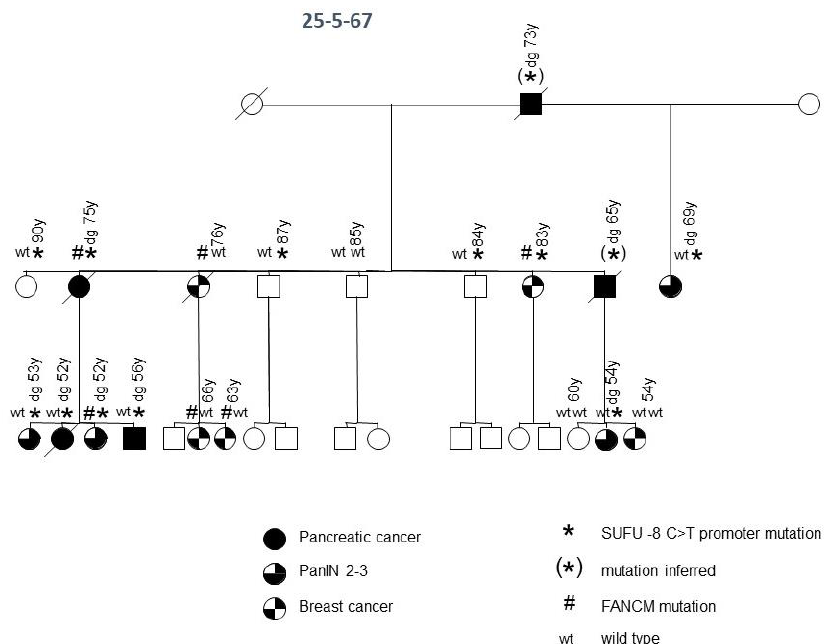
Figure 2. FPC family with SUFU and FANCM germline variants. Diagonal lines indicate deceased individuals.